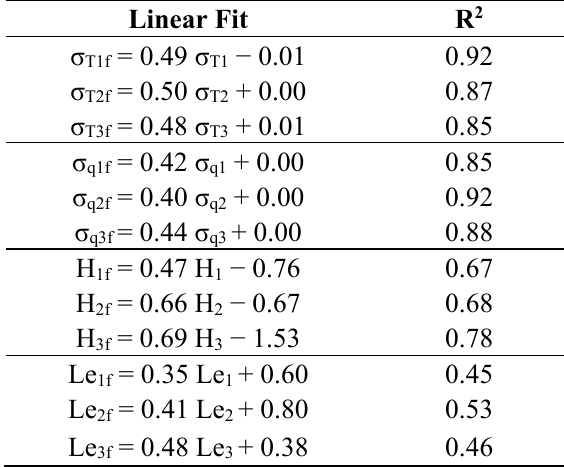
Table 3. Same as Table 2 but for turbulent statistics and fluxes computed using the original fluctuations and corrected for the wave effect, shown in Figure